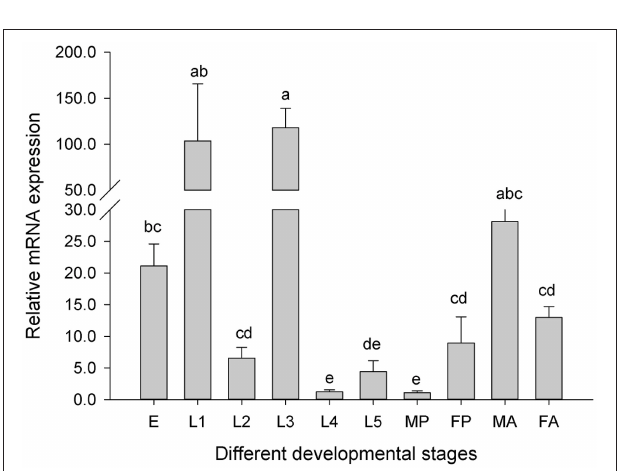
FIGURE 5 | Relative mRNA expression levels of the Cs Drip1 gene in different developmental stages of the Chilo suppressalis . E, eggs; L1, the first instar larvae; L2, the second instar larvae; L3, the third instar larvae; L4, the fourth instar larvae; L5, the fifth instar larvae; MP, male pupae; FP, female pupae; MA, male adults; and FA, female adults. Values are denoted as the mean ± SE. Significant differences are indicated as P < 0.05.